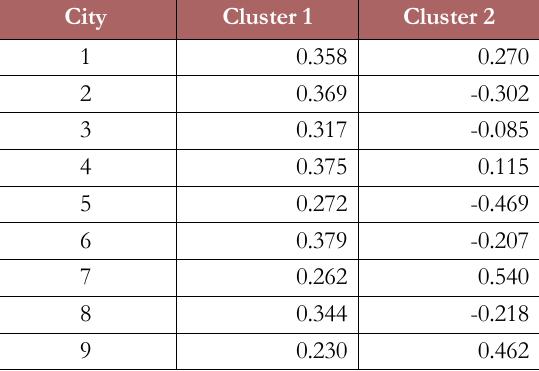
Table 5. Preliminary clusters of the hypothetical